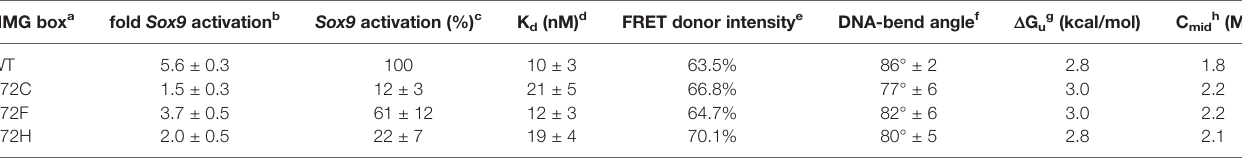
TABLE 1 | Properties of WT and variant proteins.